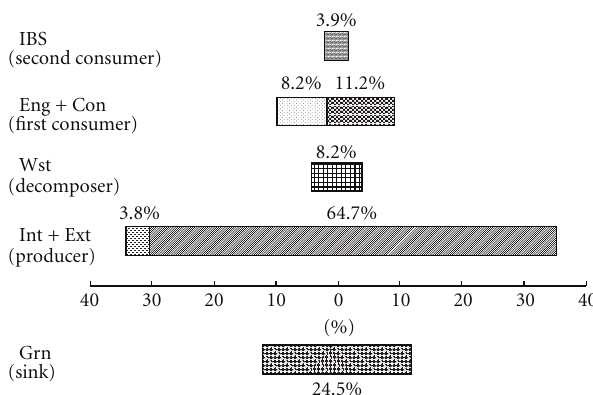
Figure 2: Ecological structure of carbon metabolism in